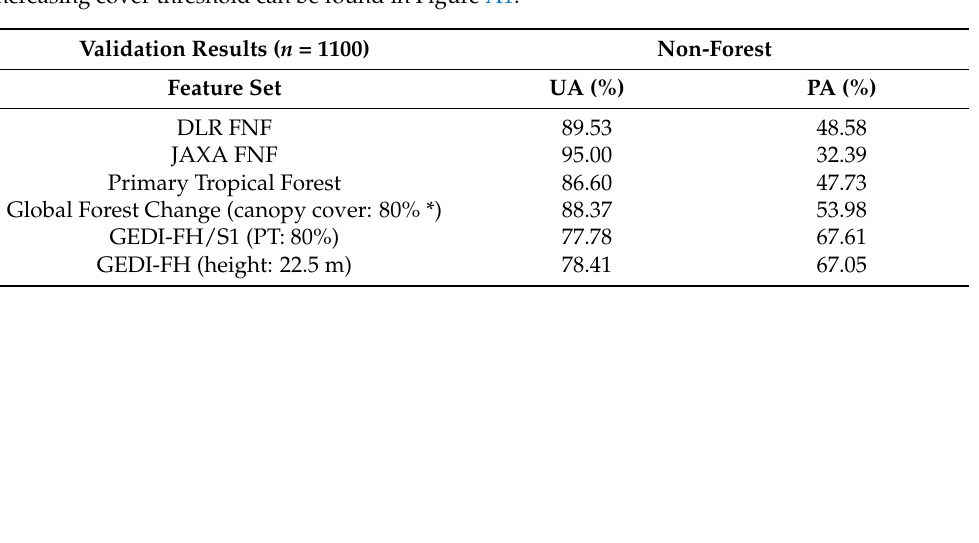
Table 4. Validation UA and PA for existing FNF masks and resultant FNF masks from GEDI-FH and GEDI-FH/S1. * A more in-depth analysis of how the validation UA and PA is affected by an increasing cover threshold can be found in Figure